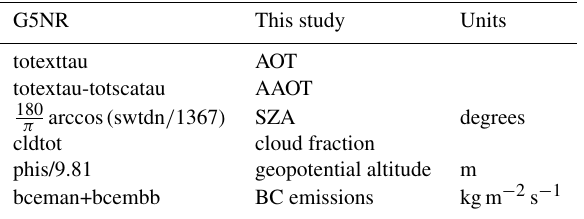
Table 2. Mapping from G5NR data to data used in this study.